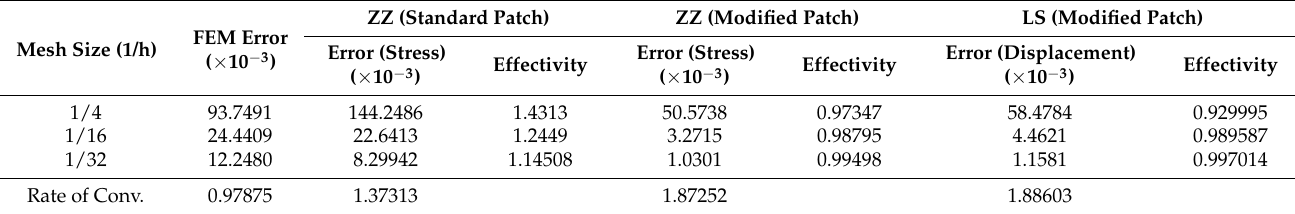
Table 1. Solution error and global effectivity for the plate problem using stress/displacement recovery and patch configura- tion (regular linear triangular element).